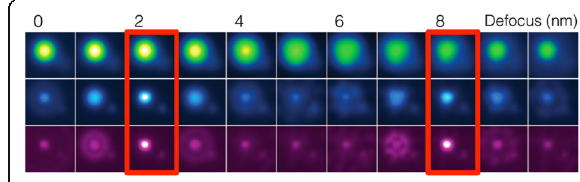
Fig. 20 Simulated focal series of images of Ce atoms substituted in AlN for probe-forming angles of 30 (upper), 60 (center), and 100 (lower) mrad at 300 kV accelerating voltage, assuming aberration- free conditions. Ce atom locations are indicated by red rectangles. Reproduced from Ishikawa et al. 2015. Copyright 2014, with permission from